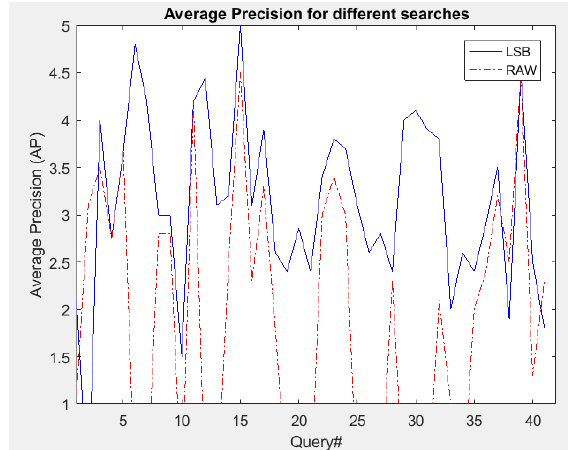
Figure 5. Average precision of‎User’s‎feedback‎for‎ different searches.